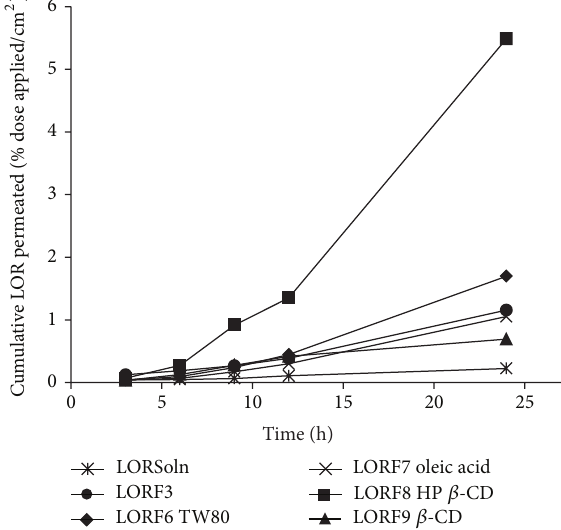
Figure5:CumulativeamountofLORpermeatedfromcarbopolgels containing different types of enhancers. Data are presented as mean ± standard deviation ( 𝑛 = 3